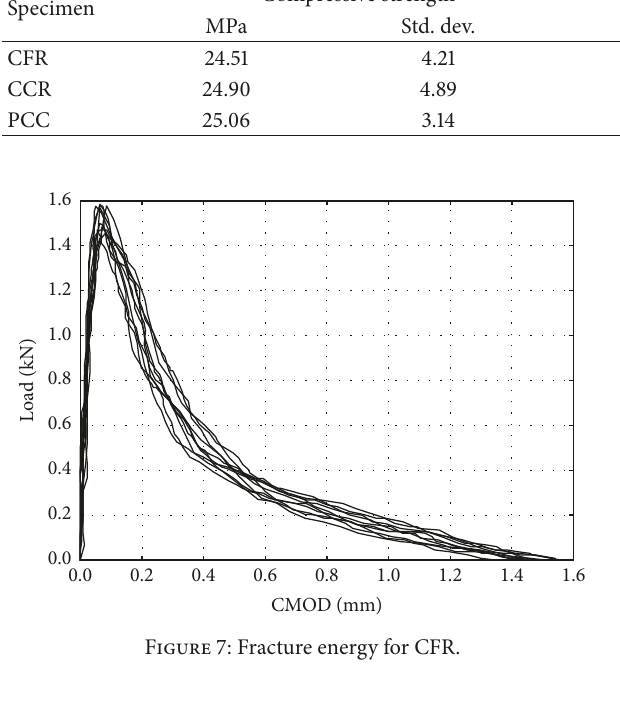
Table 3: Fracture energy for specimens of